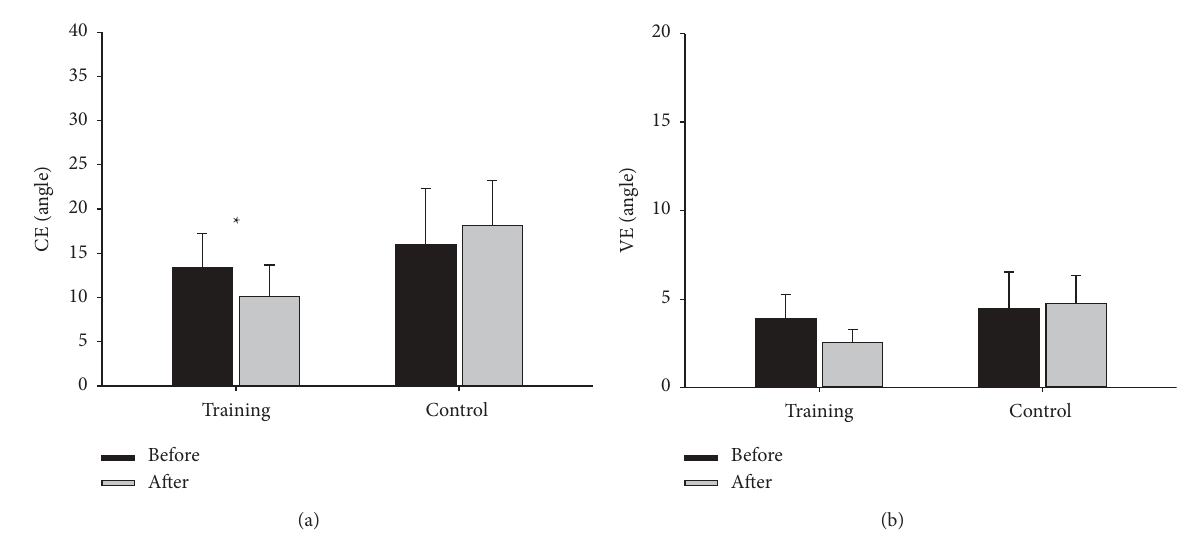
Figure 5: The group means and standard deviations of the CE (a) and the VE (b) of the training group (black bars) and the control group (gray bars) before and after 4